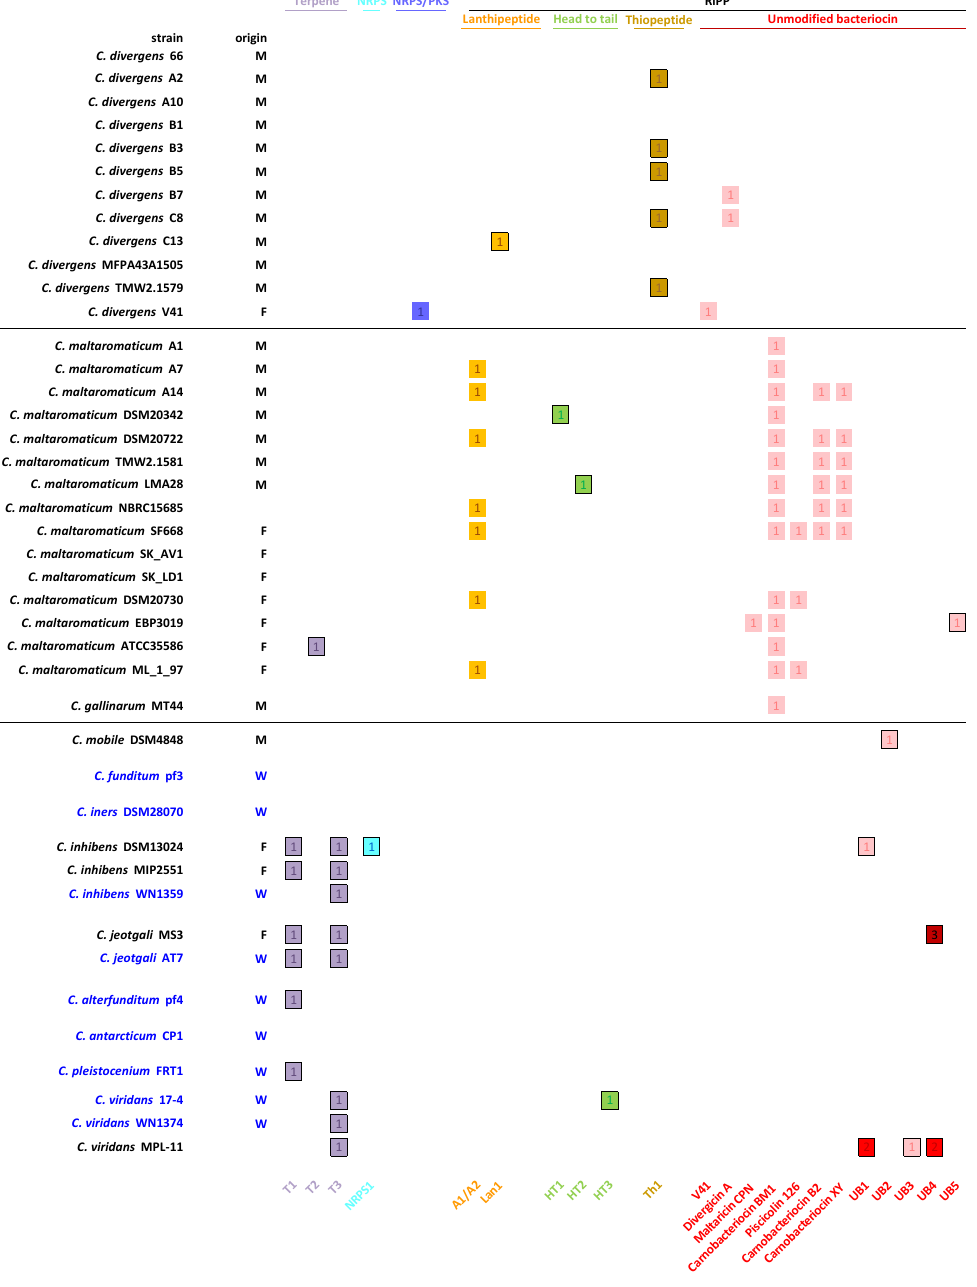
Figure 2. Predicted biosynthetic gene cluster (BGCs) in Carnobacterium spp. genomes. Numbers and color intensity indicated the copy numbers of BGCs. Strains from marine origin are colored in blue. Origin: M = meat; F = fish and seafood products; W = water. The three genomes sequenced in this study are highlighted with a red asterisk.